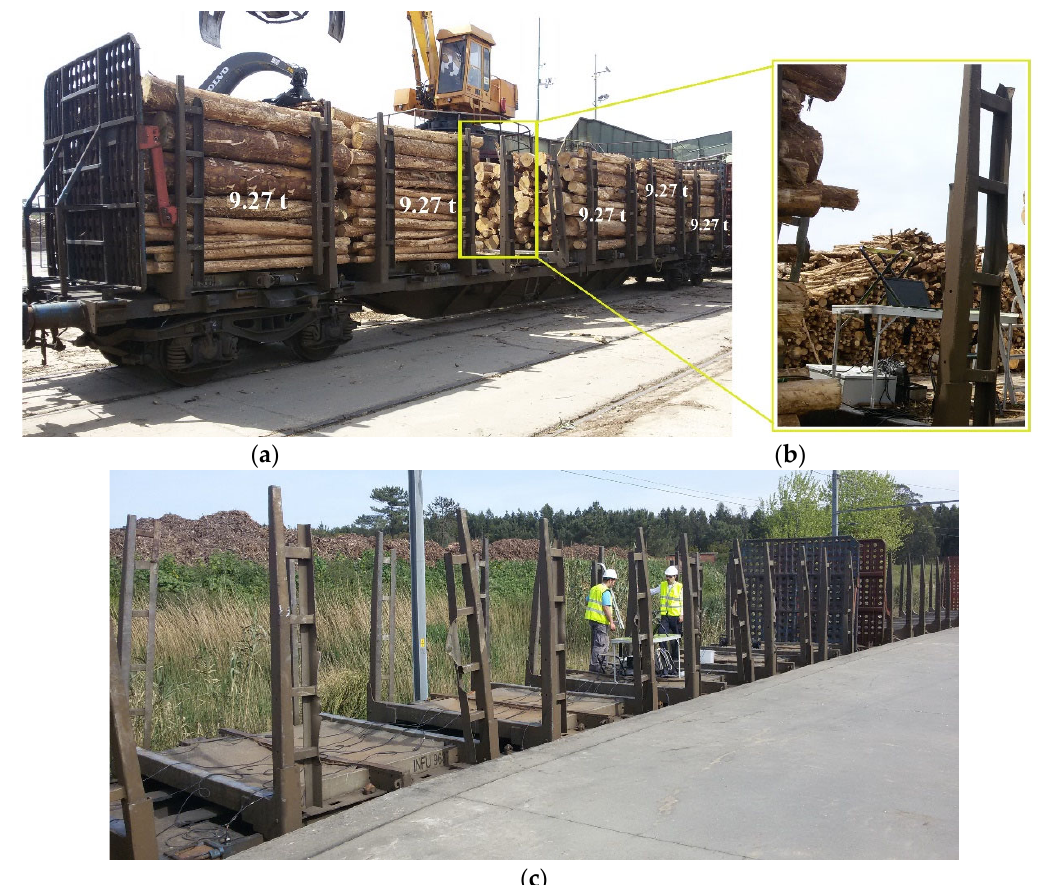
Figure 5. Dynamic tests of Sgnss wagon: ( a ) loaded configuration, ( b ) detail of the central stowage, ( c ) unloaded configuration.